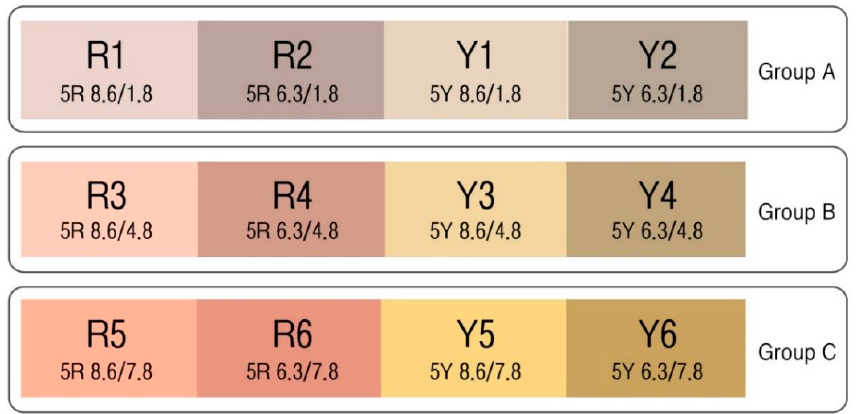
Figure 6. Order of exposure to experimental stimulus materials.